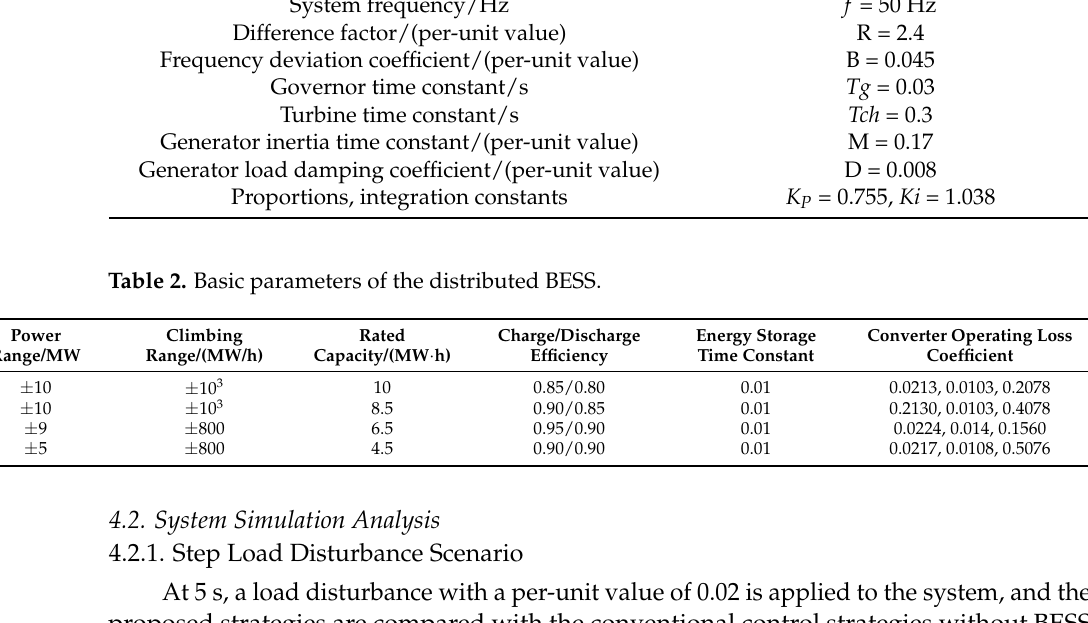
Table 2. Basic parameters of the distributed BESS.